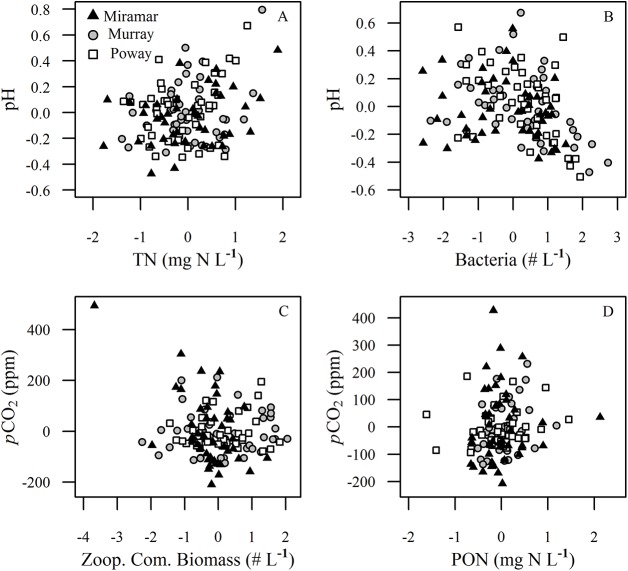
Partial regression plots of the significant drivers of pH and pCO2 across all reservoirs.Drivers were identified by the model averaging procedure pH versus (A) total nitrogen (mg N L-1) and (B) bacteria abundance (# L-1), and pCO2 versus (C) zooplankton community biomass (mg L-1) and (D) particulate organic nitrogen (mg N L-1). Symbols indicate the reservoir as shown in the legend.